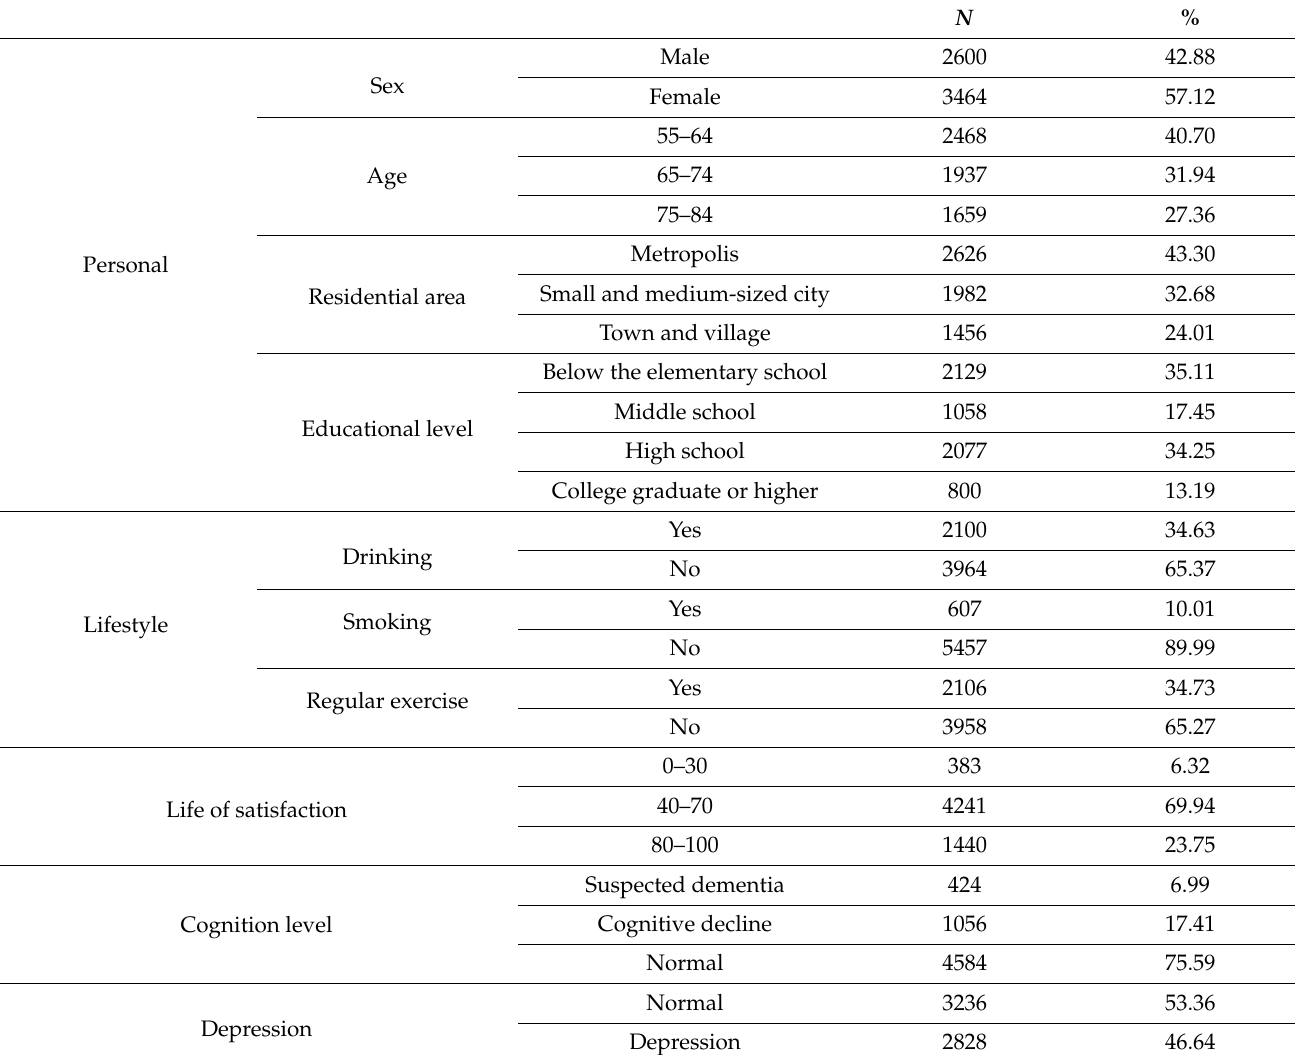
Table 1. Demographic characteristics ( N =